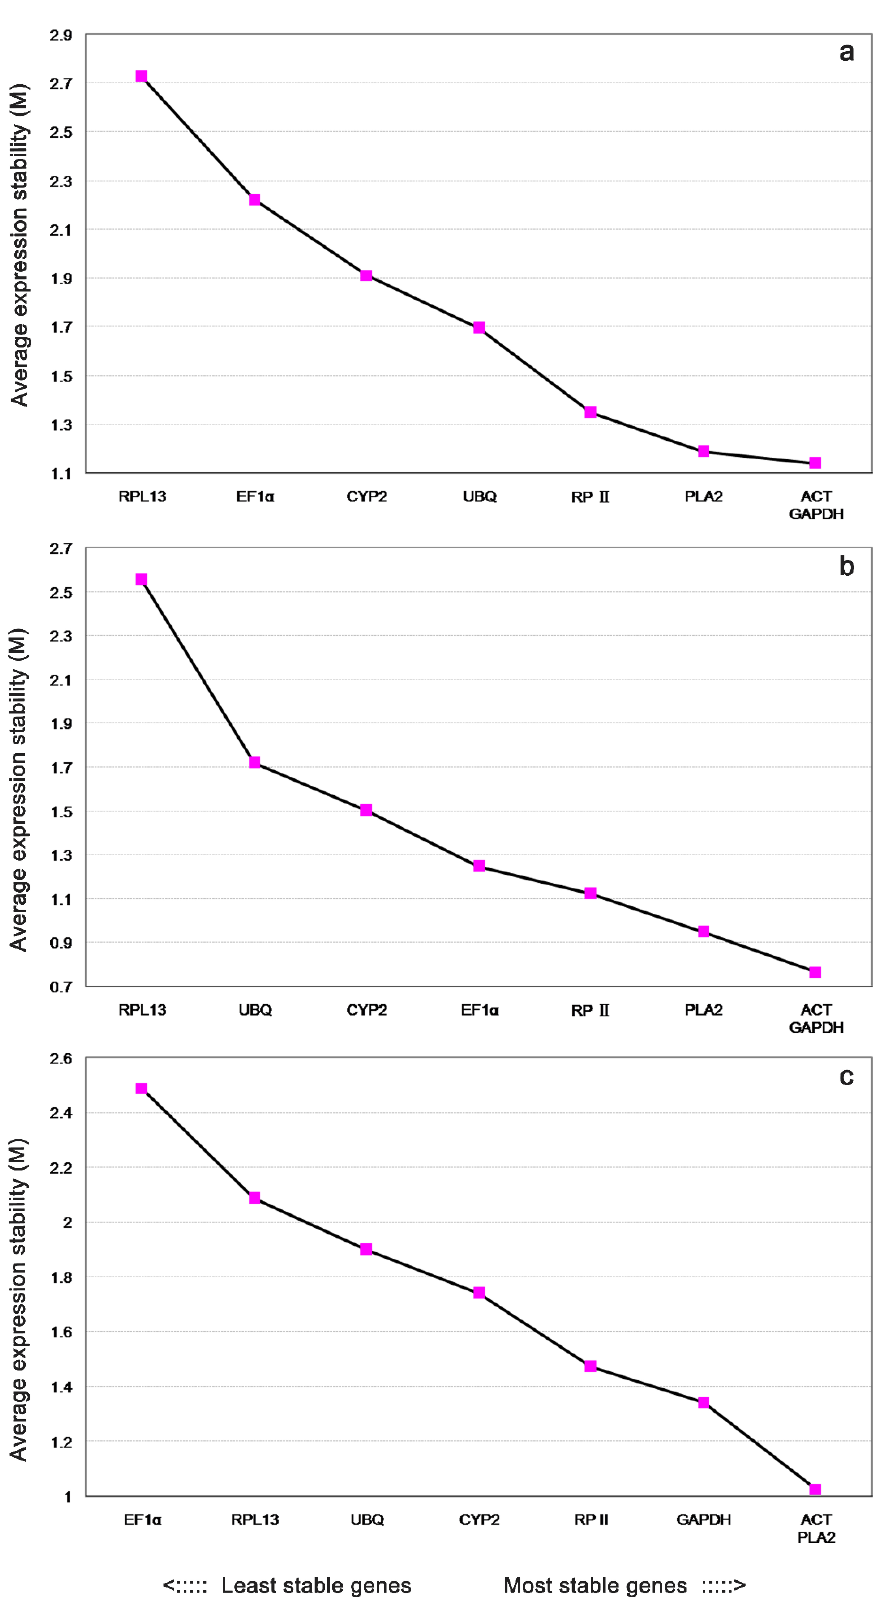
Figure 2. Gene expression stability and ranking of the eight reference genes as caculated by geNorm. Expression stability and ranking of the eight reference genes as caculated with geNorm in all samples ( a ), different vegetative tissues ( b ), and embryonic developmental stages ( c ). A lower average expression stability (M value) indicates more stable expression.